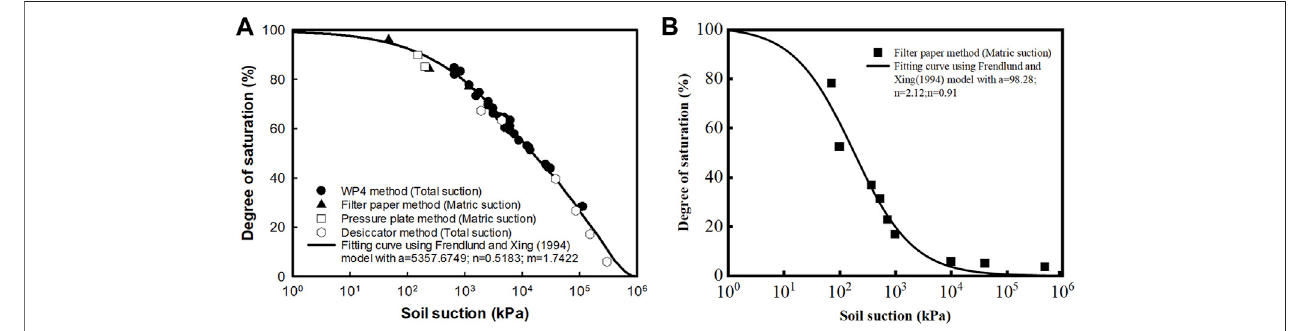
FIGURE 3 | SWCC of expansive soil and collapsible soil used in the pile in fi ltration test. [ (A) Expansive soil. (B) Collapsible soil].